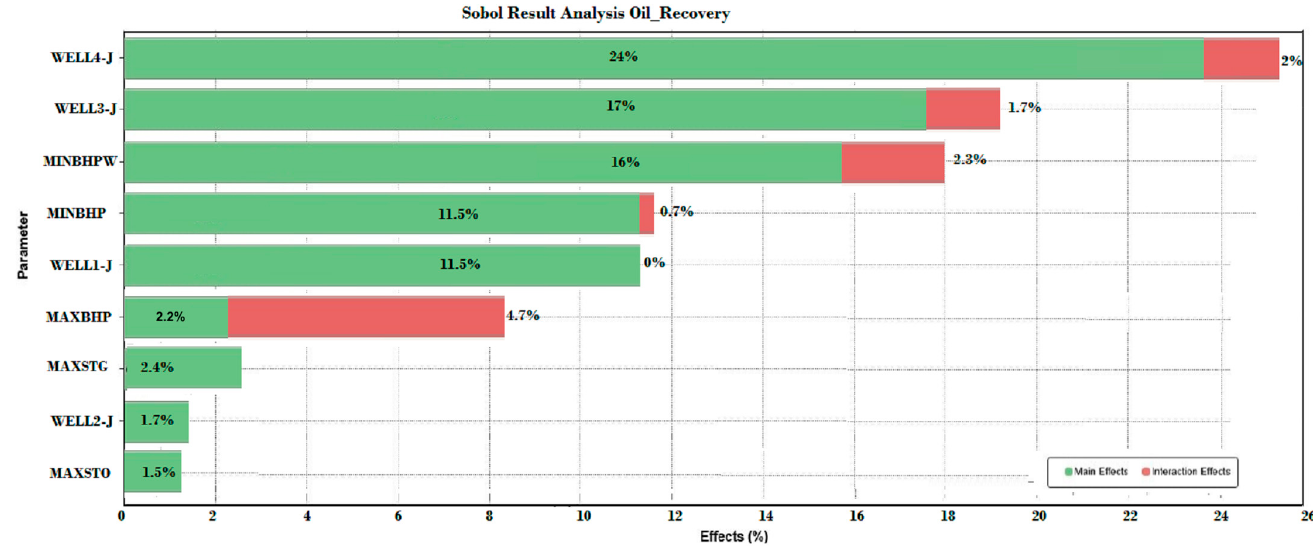
Figure 16. Sobol most influential decision variables affecting the TC-GDWS process performance using PSO, scenario 2.